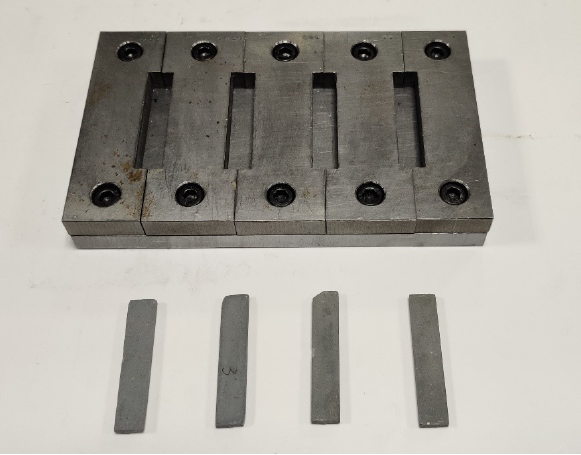
Figure 2: Damping test mold and specimens